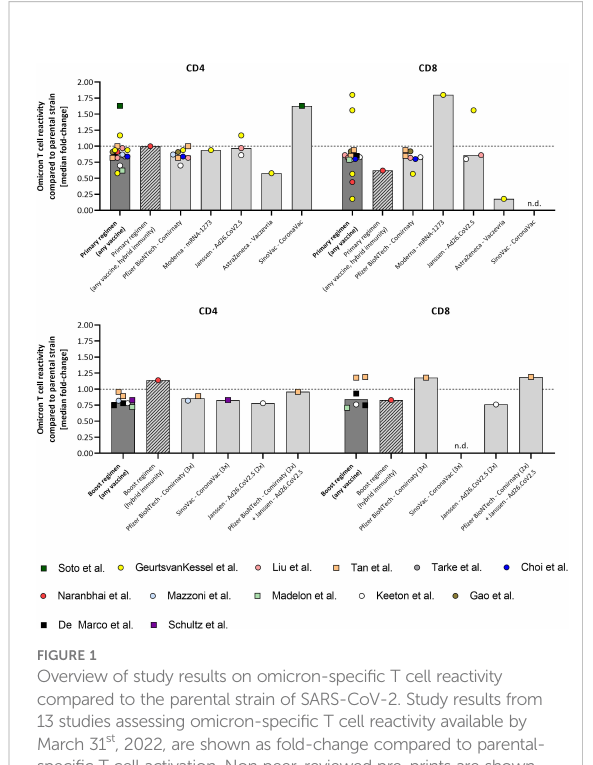
FIGURE 1 Overview of study results on omicron-speci fi c T cell reactivity compared to the parental strain of SARS-CoV-2. Study results from 13 studies assessing omicron-speci fi c T cell reactivity available by March 31 st , 2022, are shown as fold-change compared to parental- speci fi c T cell activation. Non peer-reviewed pre-prints are shown as squares. A) Data on primary vaccine regimen and B) data on booster regimen. Every data point represents a single study. Data points from the same study are depicted with the same color. Data are either presented within the manuscript or abstracted from high- resolution fi gures or raw data provided with the manuscript. “ Primary regimen (any vaccine) ” and “ Boost regimen (any vaccine) show all data points from studies on primary or boost vaccine cohorts, respectively (dark grey bars), excluding hybrid immunity shown in a separate bar (shaded bars). Data are not strati fi ed for sampling intervals and peak-immunity as well as waned immunity data sets are included. Bars indicate the median fold-change in T cell cross-reactivity to omicron, compared to the parental strain. N.d, no